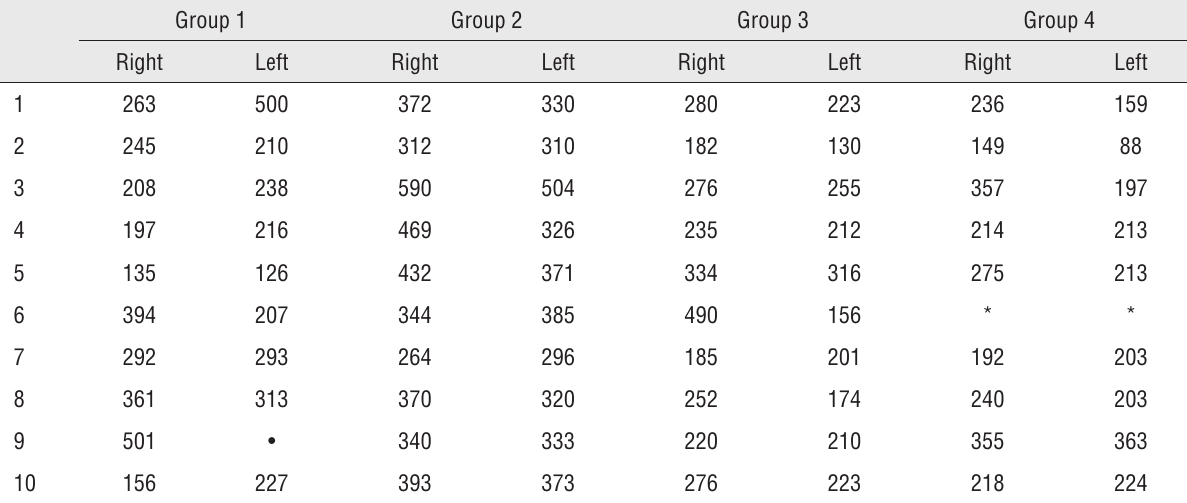
Table 4 - Actual prostate weight of the